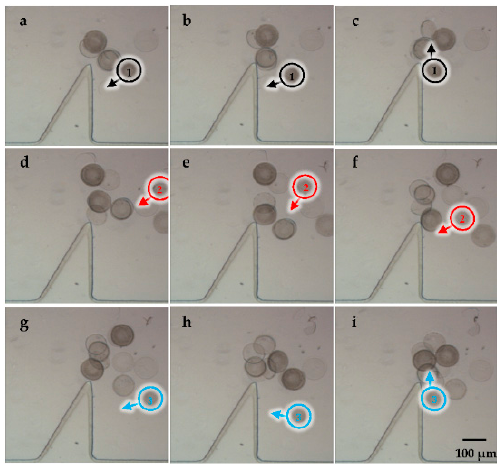
Figure 10. ( a – i ) Microscopic images of the multiple diatom cells trapped by adjusting the frequency.